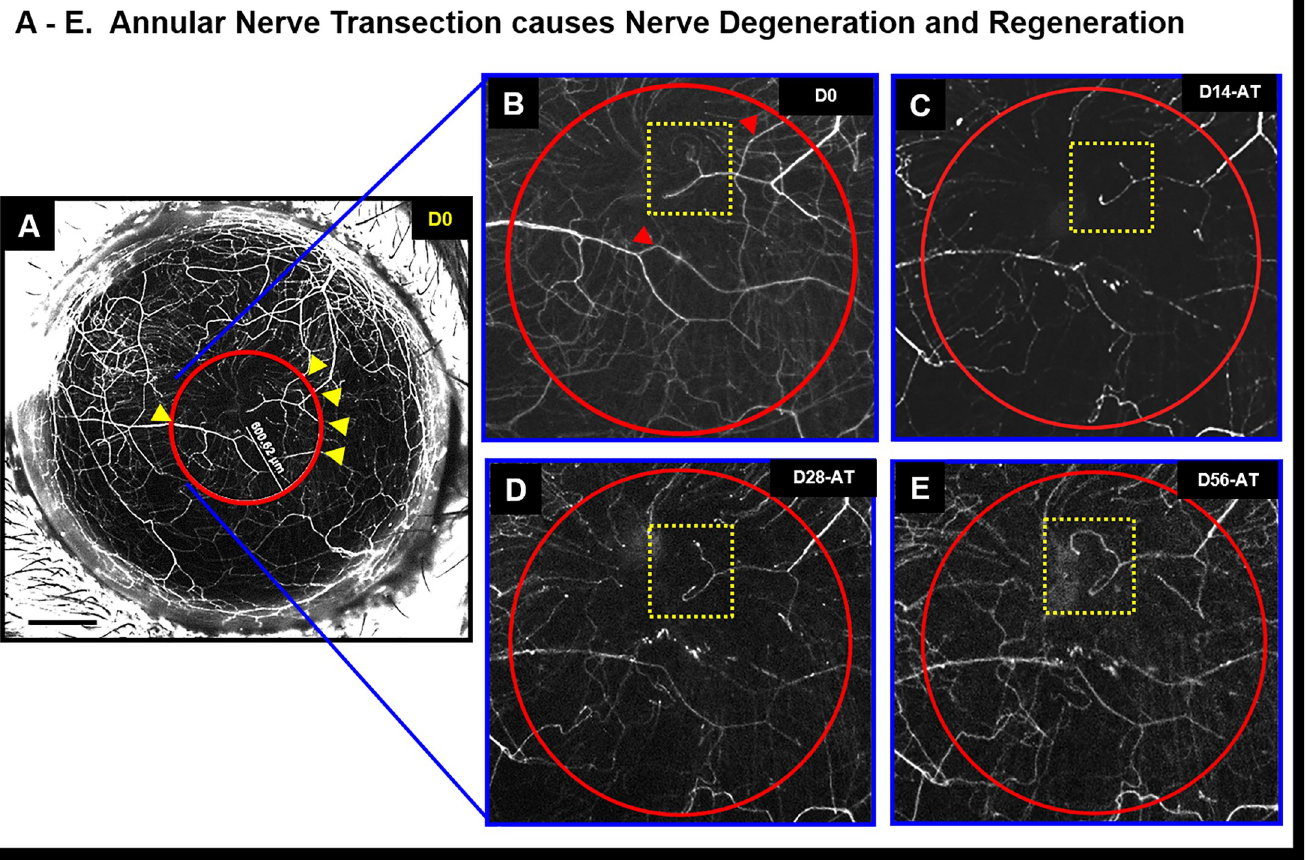
Fig 8. Annular nerve transection causes nerve degeneration and regeneration. Stereolumar image of annular nerve transection shows disappearance, reappearance or retention of nerve fluorescence. The yellow arrow heads depict positions of the nerve cuts within an area demarcated by the red circle. Panels B, C, D and E show magnified area within the red circle showing nerve changes corresponding to different time points after surgery (Days 0, 14, 28 and 56 respectively). The red arrow heads (Panel B) show nerve degeneration at different time points (Panels C–E). The yellow dotted area inset shows area of aberrant nerve regeneration; Black scale bar in Panel A: 500 μ m; AT refers to “after